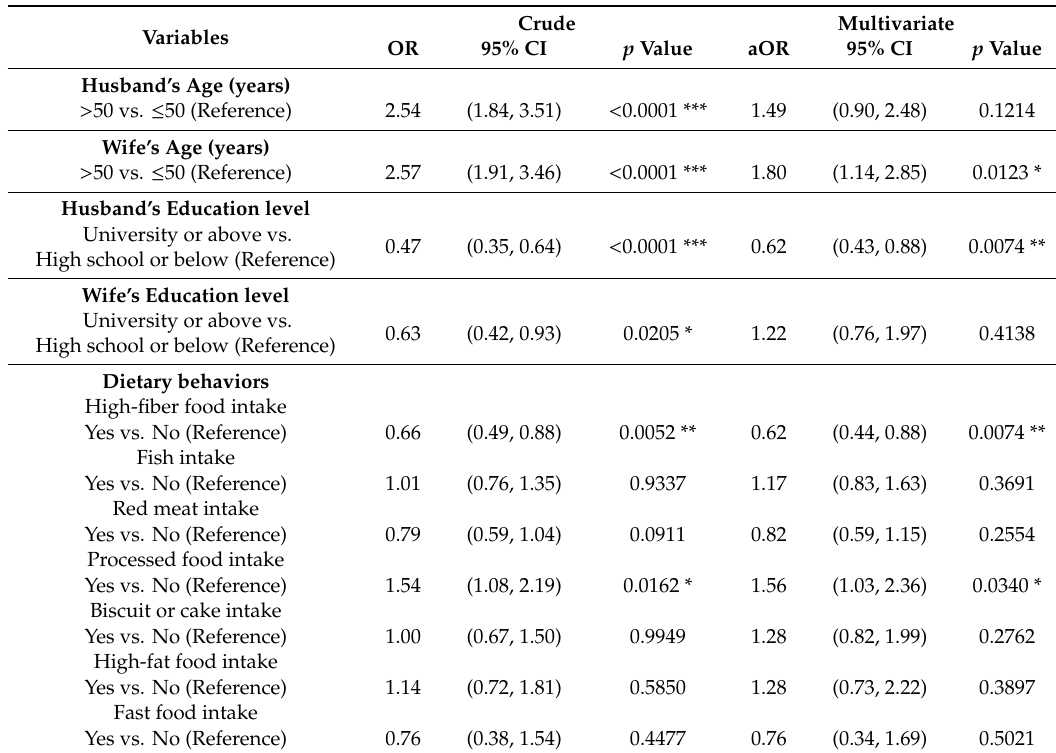
Table 4. Logistic regression for the associations between concordant dietary behaviors and concordant composite MCs among spouses ( n = 901